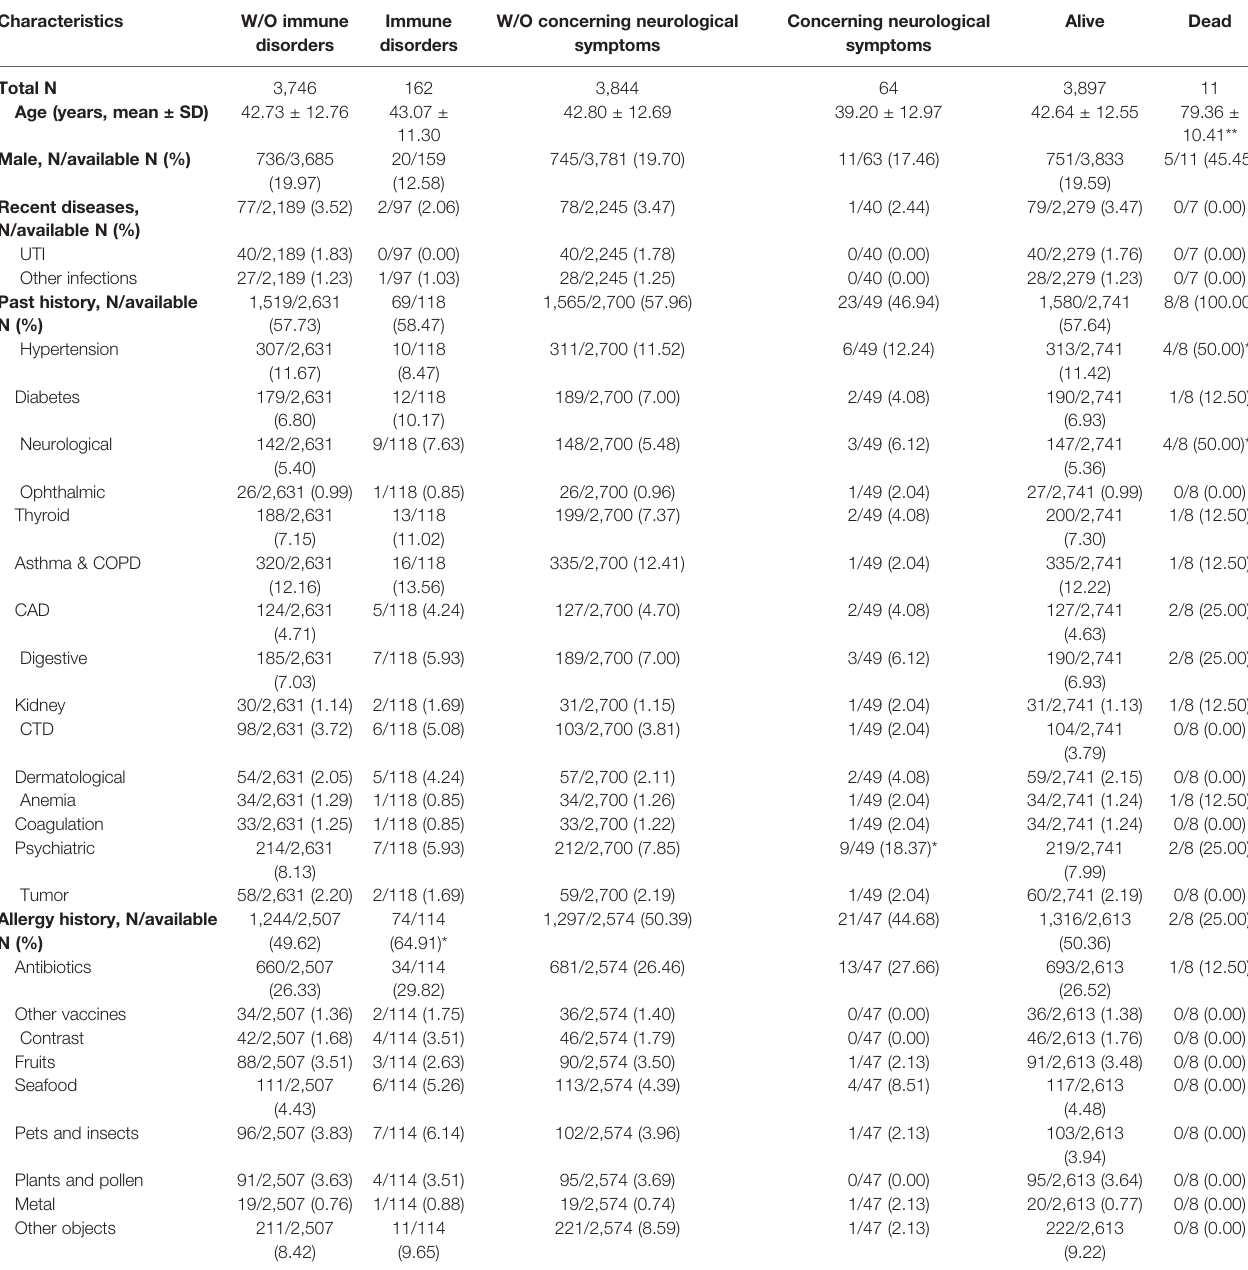
TABLE 2 | Comparison of characteristics in cases with AEs after COVID-19 vaccine sourced from the VAERS database in December